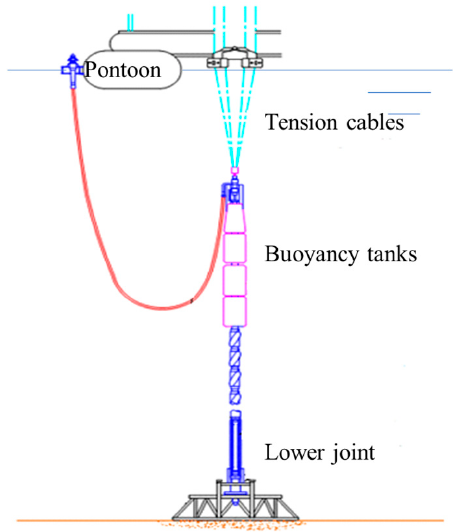
Figure 1. A model of a top-tensioned riser.